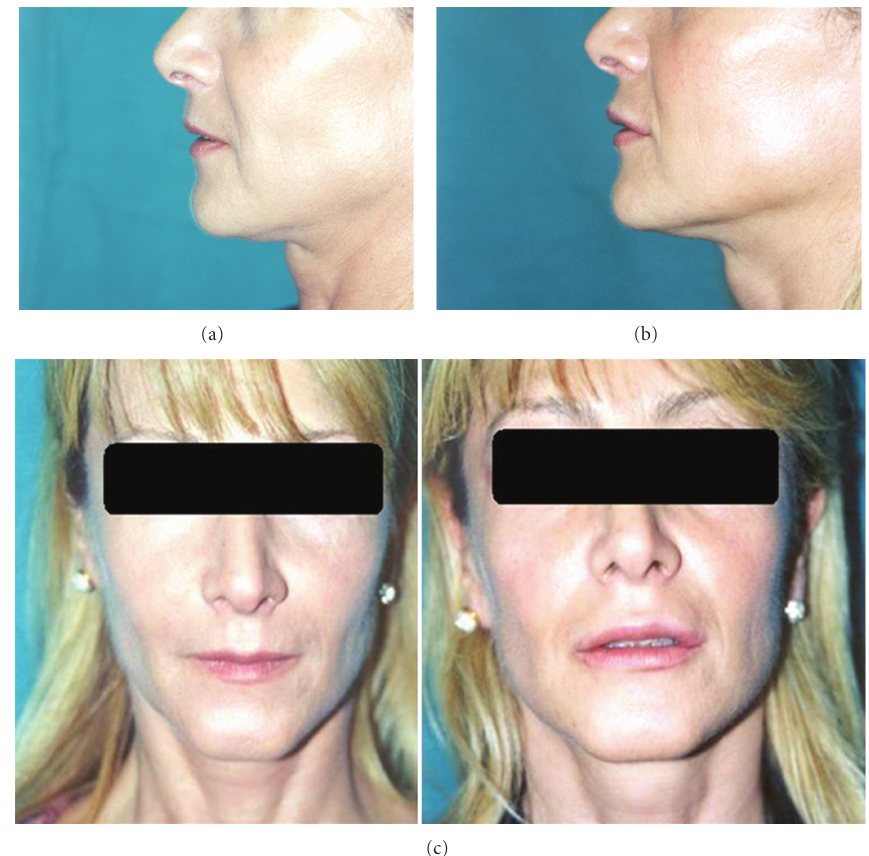
Figure 3: (a, b) are pre- and postoperative results after 20 months. (c) is pre- and postoperative result after 20 months in frontal